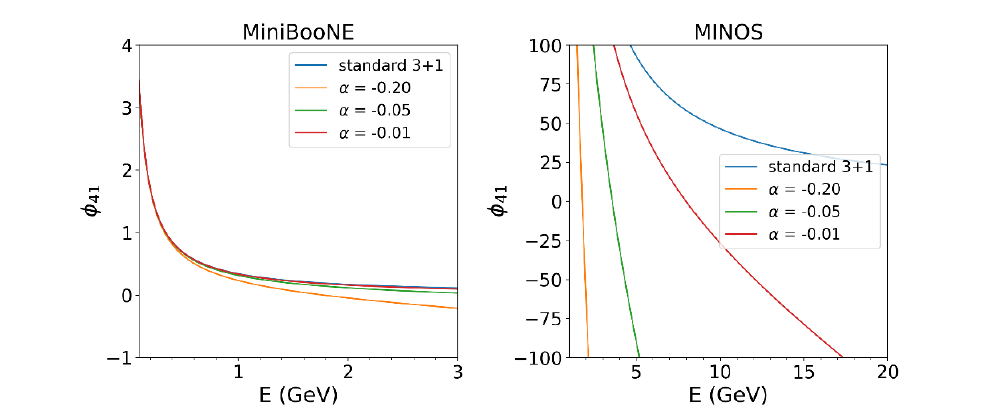
Figure 2 . The kinematic phase (cid:30) 41 as a function of the energy for MiniBooNE ( L = 0 : 541 km) and MINOS ( L = 731 km). Di(cid:11)erent values of (cid:11) are also